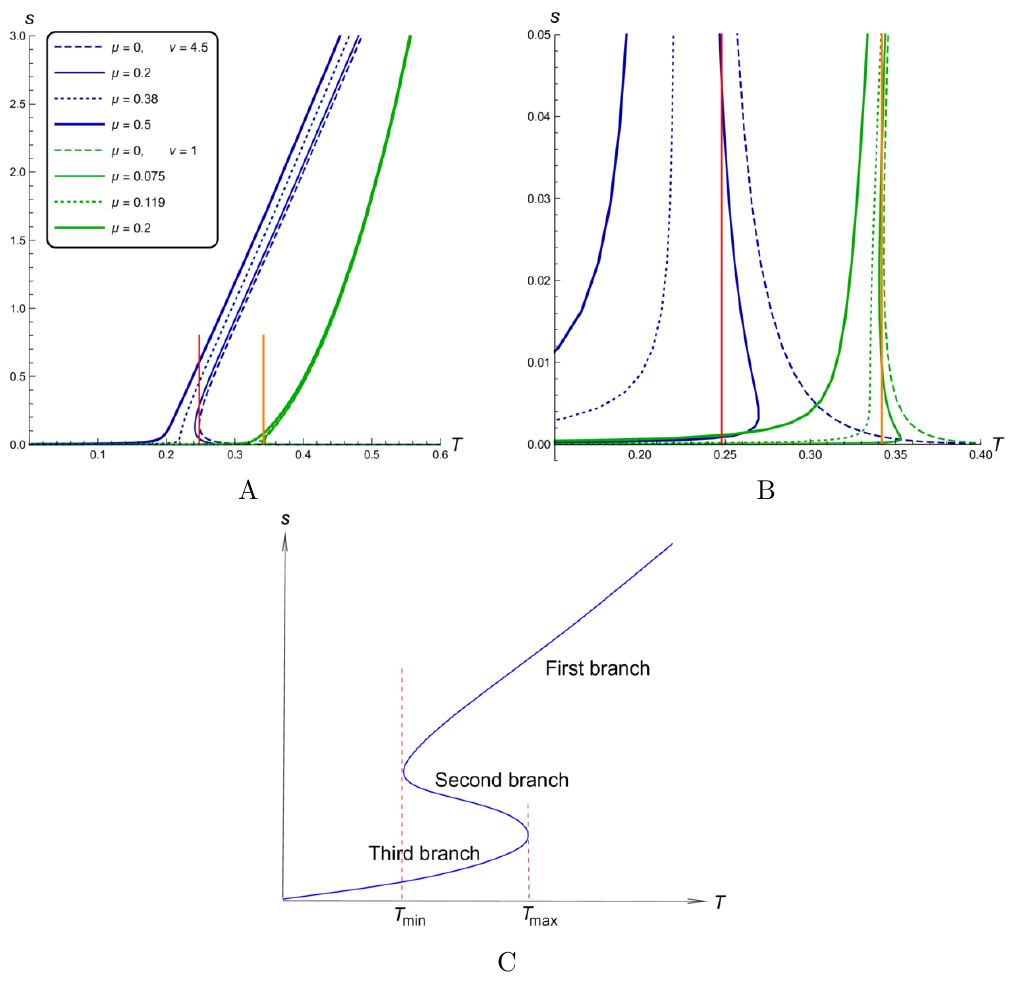
Figure 24 . The black hole entropy s ( T ) for di(cid:11)erent (cid:22) and c = (cid:0) 1 in isotropic (green lines) and anisotropic case (blue lines) (A); a region of (A), located near the minimum temperatures T min ( c; (cid:23) ), in increased scale (B), where the red vertical line indicates T min ( (cid:0) 1 ; 4 : 5) = 0 : 245 and the orange one indicates T min ( (cid:0) 1 ; 1) = 0 : 355 for (cid:22) = 0; the schematic view of s ( T ) three-branches behavior